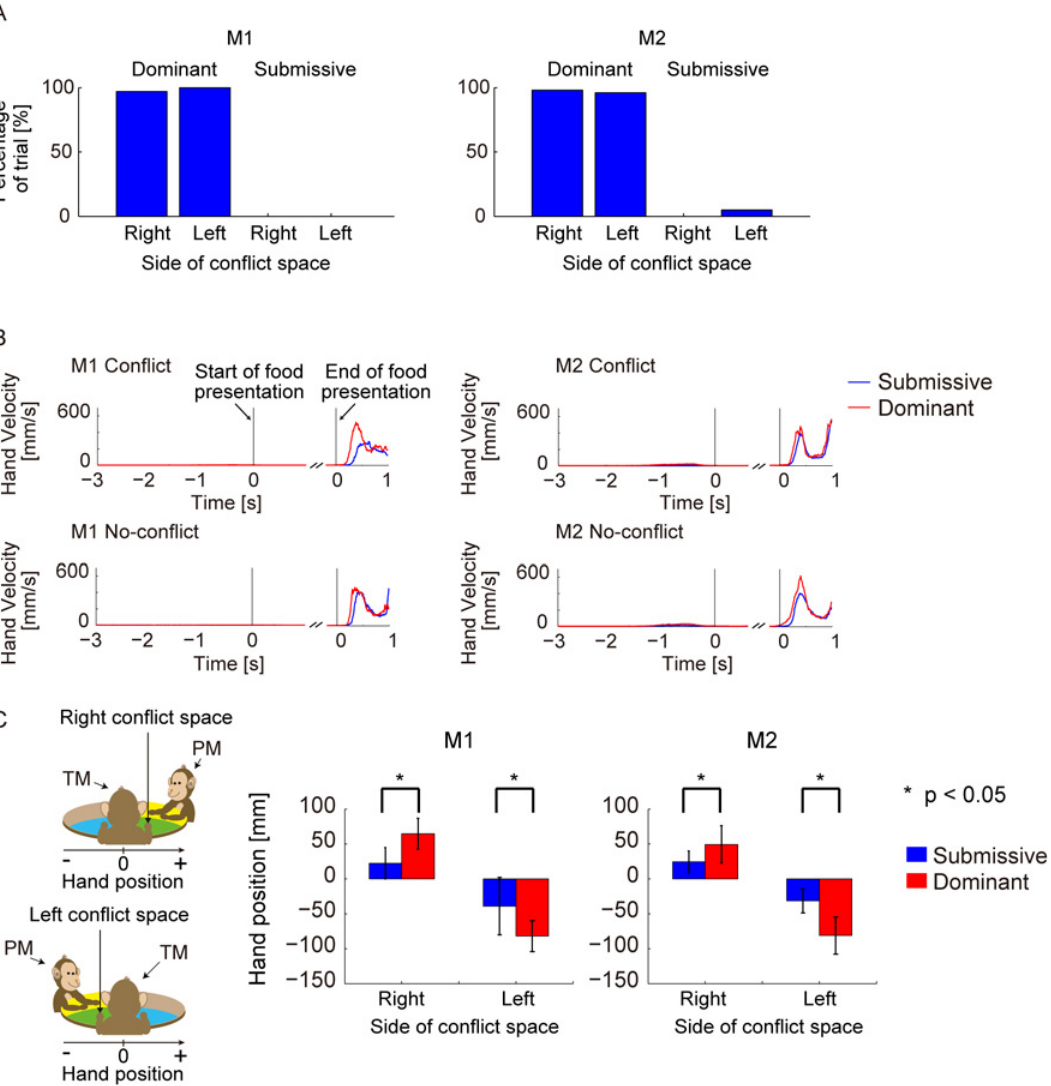
Fig 4. Behavioral evidence for social adaptation. A. The bars indicate the rates for each trial in which the TM tried to reach the food when the food was placed in the conflict space in the dominant and submissive conditions. When the conflict space was to the right or left side of the TM, the TM used its right or left hand, respectively, to reach for the food. The percentages of trials in which the TM moved its right or left hand toward the right or left conflict space are displayed in a bar graph for each social condition. B. Velocity of hand movement of the TM was plotted for the conflict (upper figure) and no-conflict (lower figure) conditions and for the submissive (blue line) and dominant (red line) conditions. The x-axis indicates time. Time zero on the left side of each panel shows the relative time around the start of the food-presentation period, and time zero on the right side of each figure shows the relative time to the end of the food-presentation period. Around the start and end of the food-presentation period, the velocities of the TM ’ s reaching motion were pooled for both the left and right arms for each conflict and no-conflict condition and for each submissive and dominant condition. Around the end of the food-presentation period in the conflict condition, we pooled only the velocities of the right and left hands used by the TM to reach food in the no-conflict space on the TM ’ s side. Around the end of the food-presentation period in the no-conflict condition, we pooled the velocities of the right and left hands used by the TM to reach food on the right and left sides of the TM. The median pooled values were calculated as the velocity of hand movement at that point. C. Bar graph showing the average relative hand position of the TMs on the side of the conflict space during the time window around the start of food presentation from – 3000 ms to 1000 ms for M1 and from – 3000 ms to 625 ms for M2. In the right- or left-side condition, the mean value of the position of the right or left hand was calculated for each social condition. The axis of the hand position was set to be parallel to a line perpendicular to the line from the center of the TM ’ s body to the center of the table. Error bars indicate the SDs of the hand